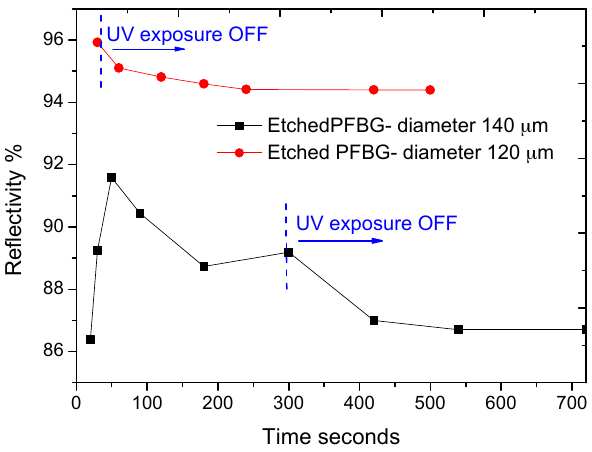
Figure 4. Evolved reflectivity of the etched PFBGs when the exposure is OFF at peak reflectivity and exposure is OFF after 5 min.